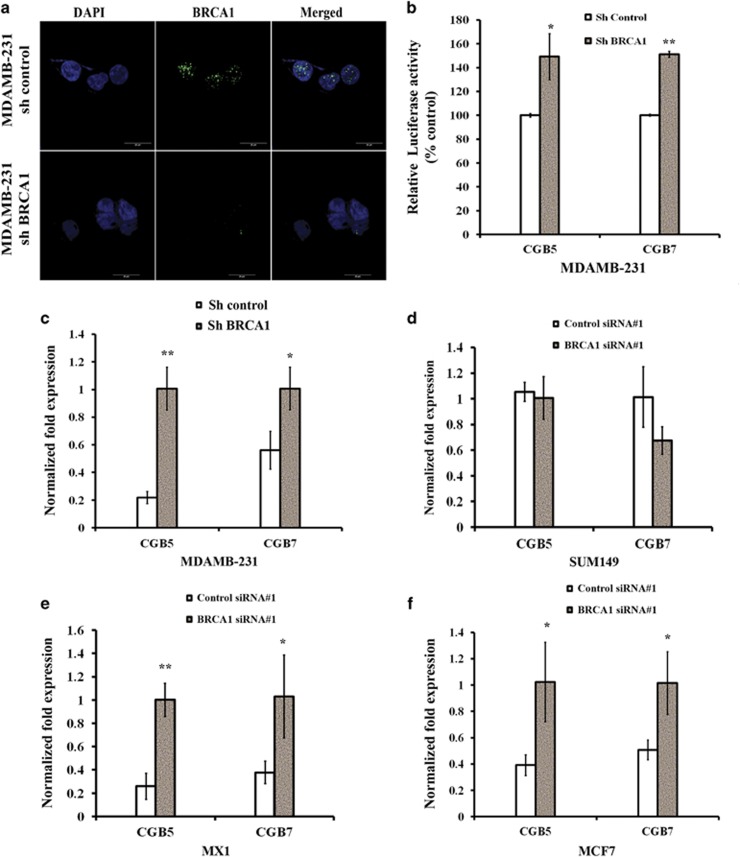
Loss of BRCA1 transcriptionally induces β-hCG expression in different breast cancer cells. (a) Immunoflourescence analysis of stable knockdown of BRCA1 in MDAMB-231 cells. (b) Relative Luciferase activity of CGB5 and CGB7 upon stable knockdown of BRCA1 in MDAMB-231. Stable clones of control shRNA transfected MDAMB-231 cells served as control. Relative luciferase units were expressed as percentage of control. (c) qRT-PCR analysis of CGB5 and CGB7 expression upon stable knockdown of BRCA1 in MDAMB-231. Expression was normalized to control shRNA transfected stable MDAMB-231. qRT-PCR analysis of CGB5 and CGB7 expression in (d) SUM149 (e) MX1 and (f) MCF7 upon silencing BRCA1. Expression was normalized to control siRNA transfected SUM149, MX1 and MCF7, respectively.